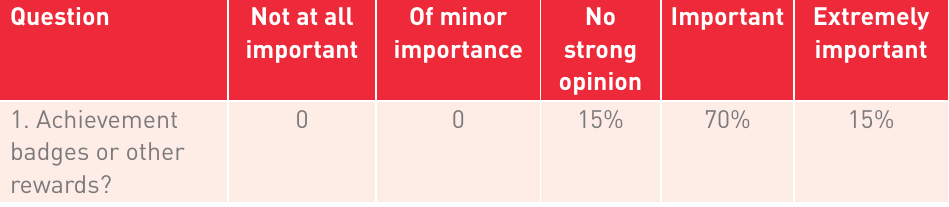
Responses to question 5 in Table 4